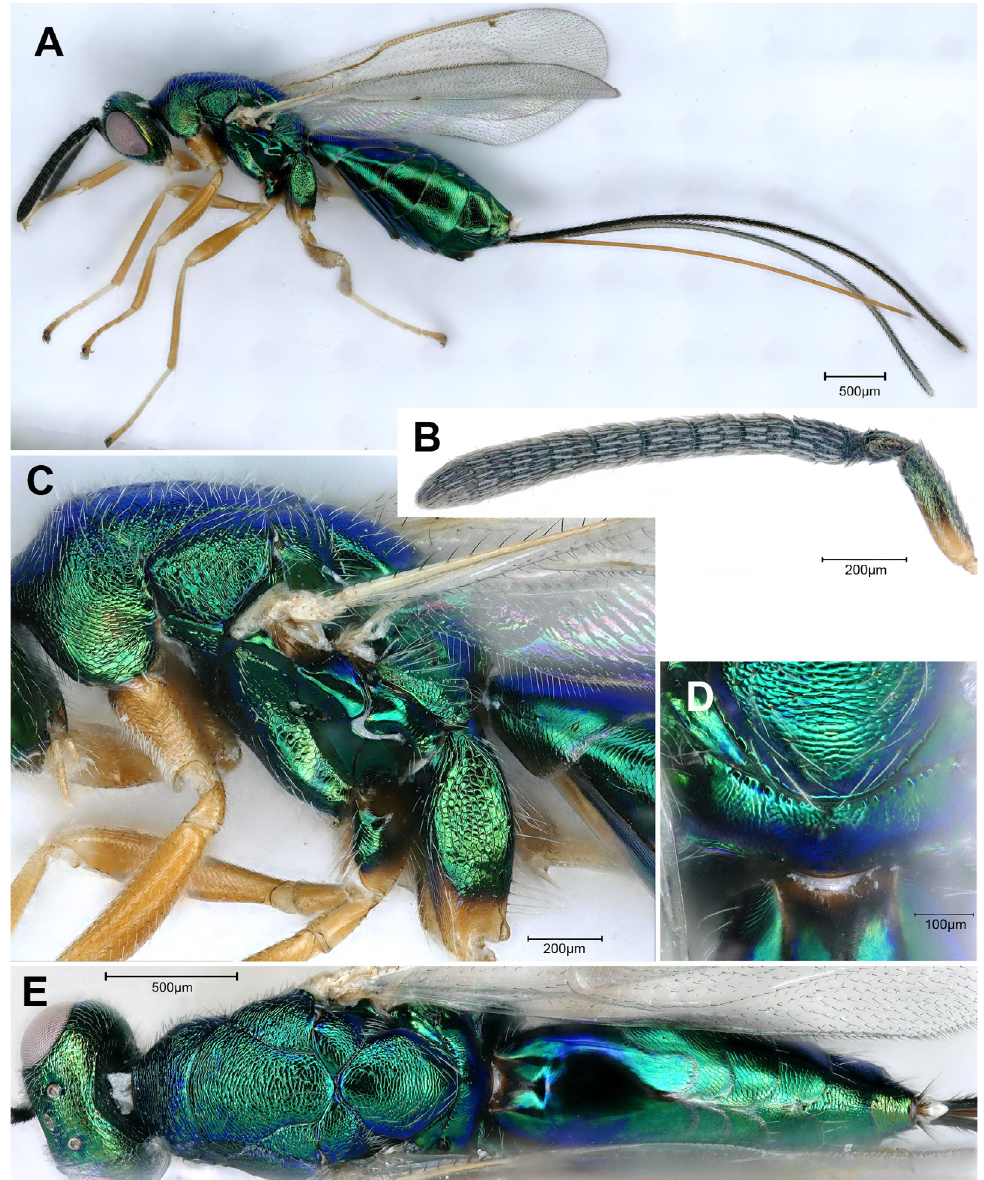
Fig. 17. Torymus arundinis (Walker, 1833). A . Female in lateral view. B . Antenna of female. C . Mesosoma in lateral view. D . Female in dorsal